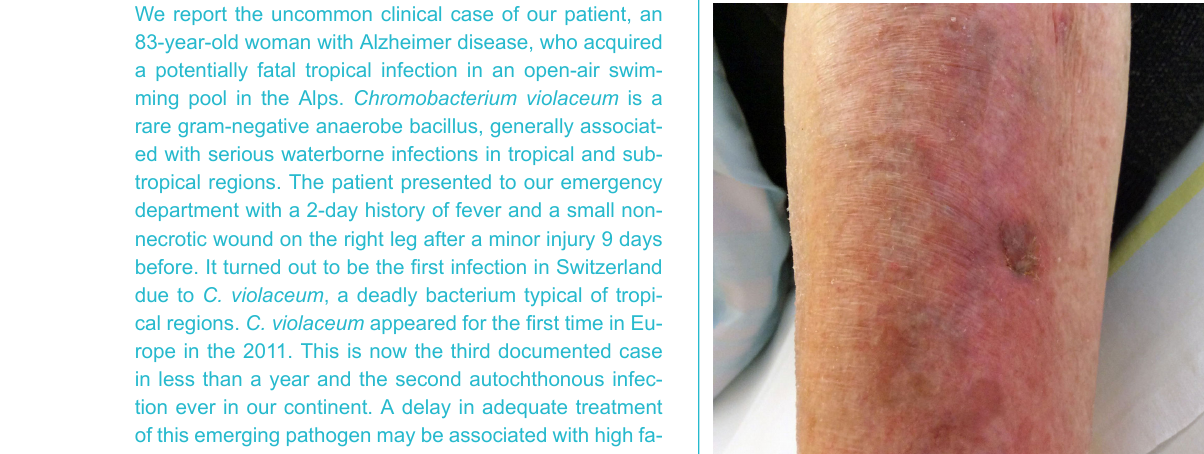
Figure 1: Initial aspect of the pretibial